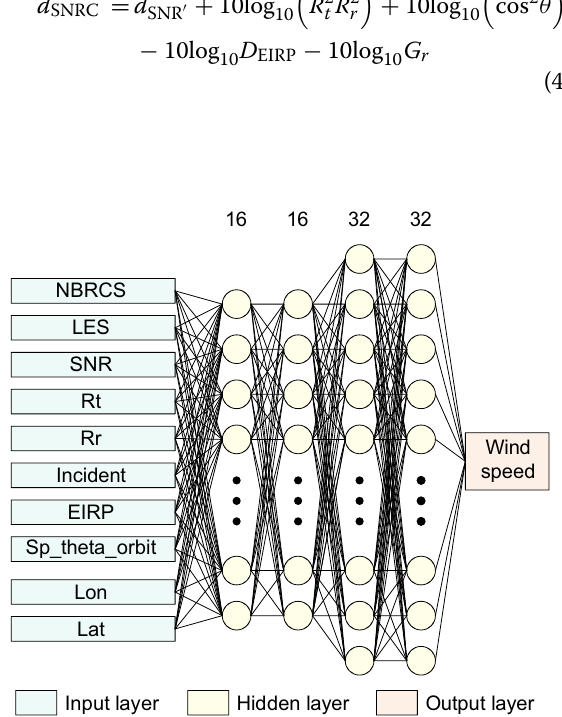
Fig. 7 Simplified visualization of the multilayer